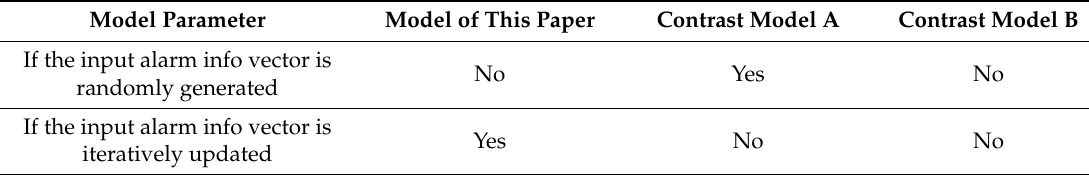
Table 5. Comparison model